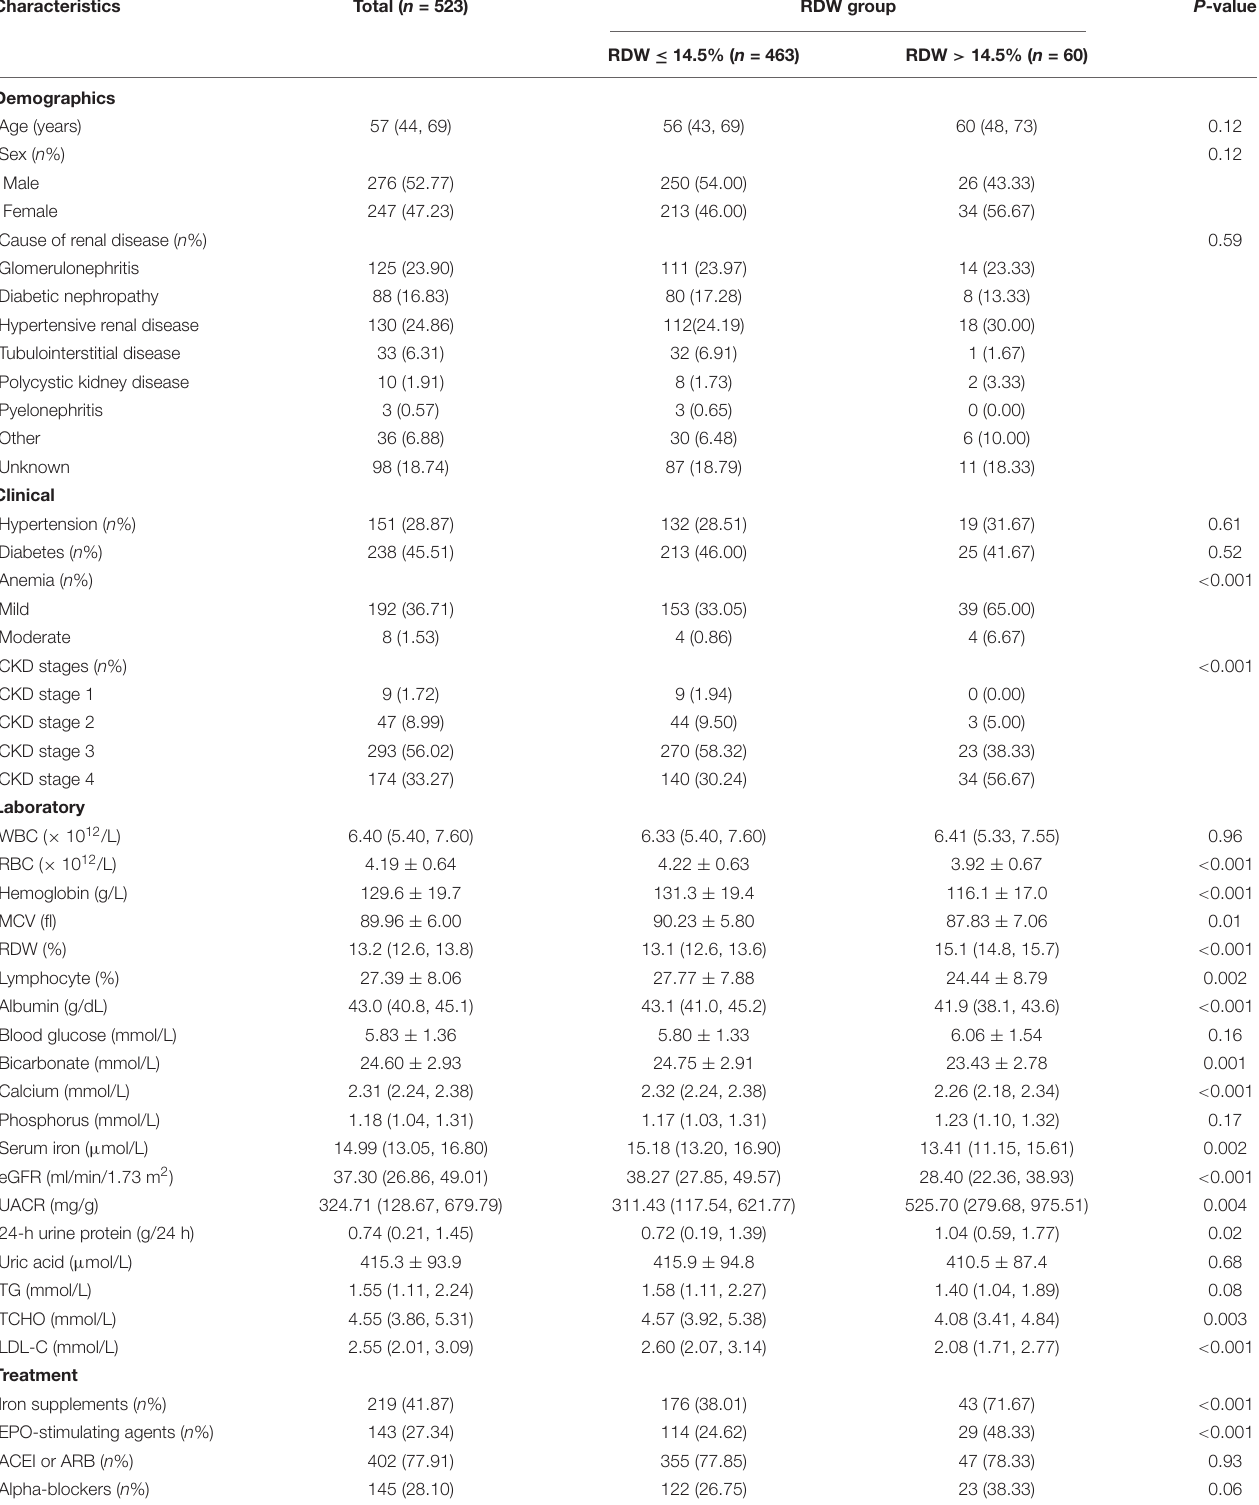
TABLE 1 | Baseline characteristics of the study populations according to the RDW level.